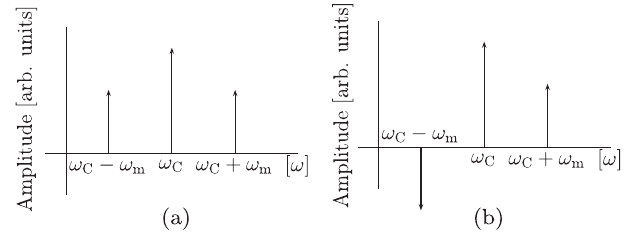
FIG. 2. Example for amplitude (a) and phase (b) modulation in frequency